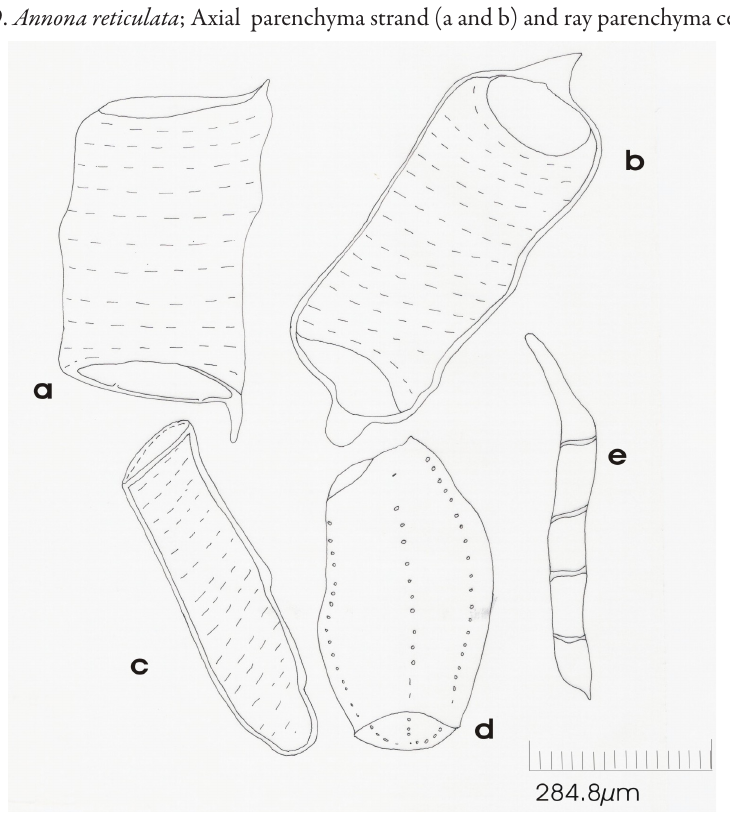
Fig. 10. Annona squamosa ; Wide vessels (a, b and